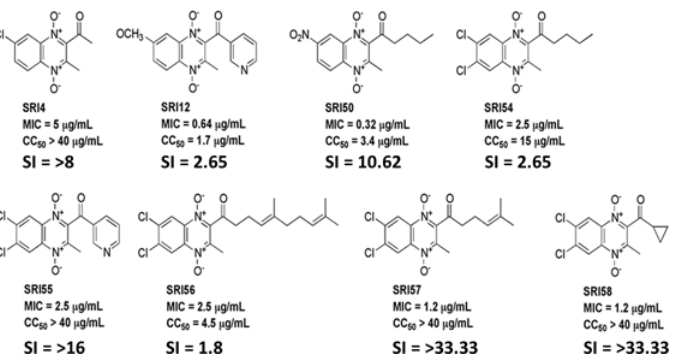
Fig 3. Structures of quinoxaline di- N- oxides with the most promising antitubercular activities and selectivities.